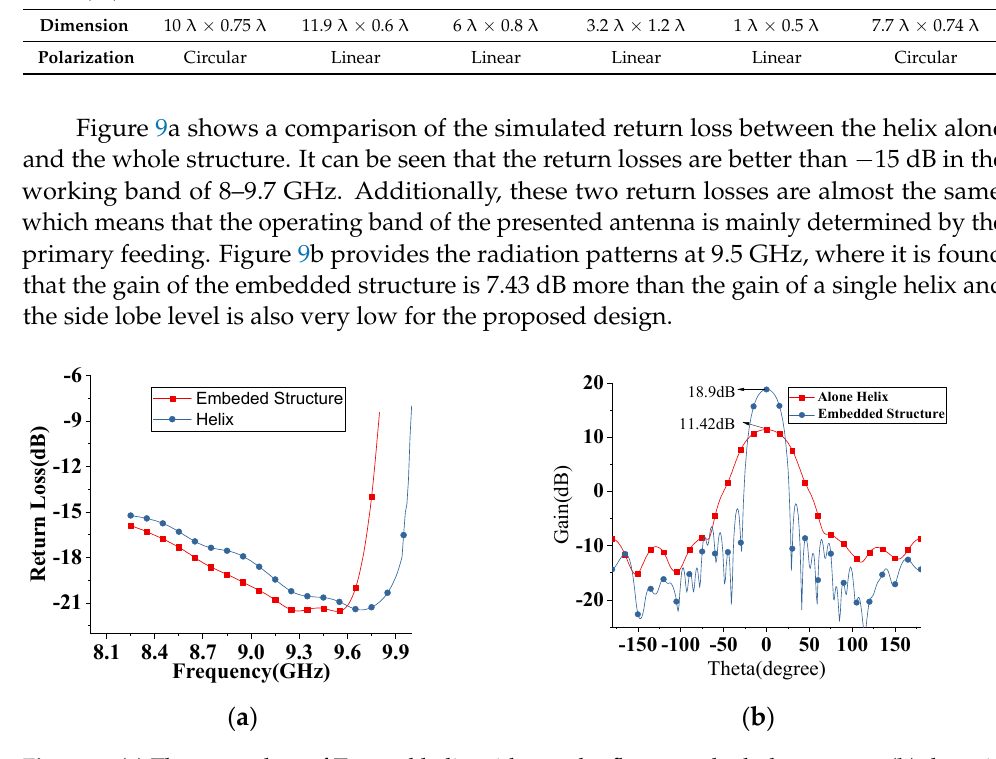
Figure 9. ( a ) The return loss of Tapered helix with metal reflector and whole structure ( b ) the gain comparison of Helix and whole structure.